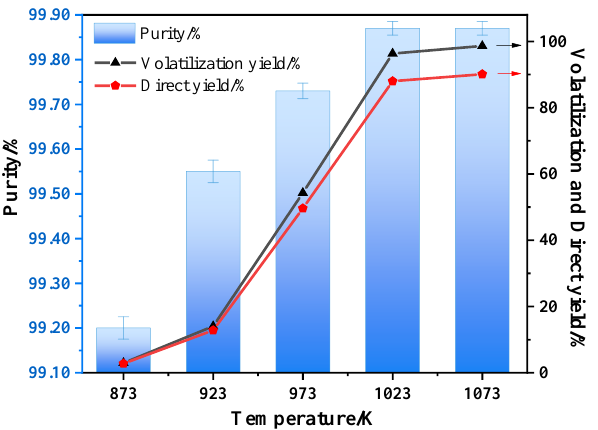
Figure 3. Magnesium purity, direct yield, and volatilization in relation to distillation temperature.